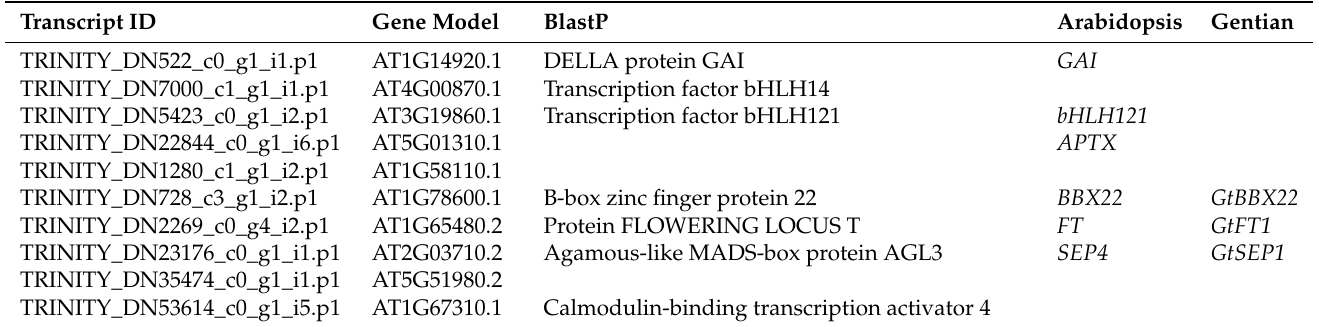
Table 4. Coexpressed transcription factor genes with GtFT1 during development over three